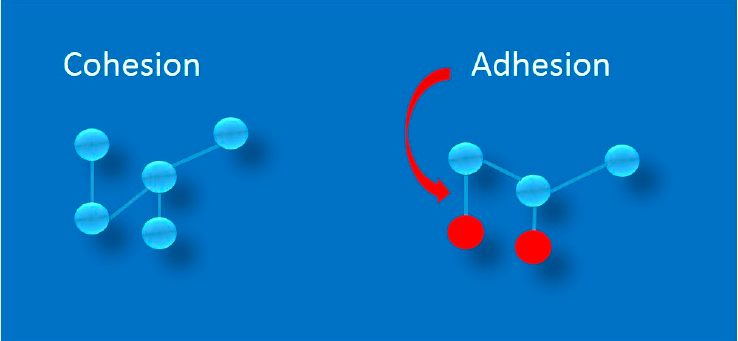
Figure 1. Schematic diagram showing the physicochemical principles of adhesion and cohesion, indicating the differences between these phenomena. Blue spheres represent similar or identical molecules, e.g., water, while red spheres represent different molecules, e.g., nitrogen.